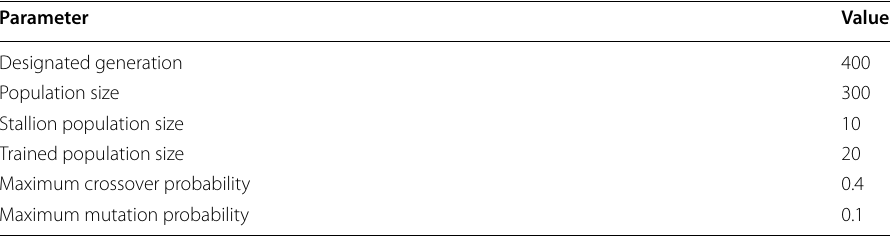
Table 2 Configuration of MOGA Parameter Values Designated generation 400 Population size 300 Stallion population size 10 Trained population size 20 Maximum crossover probability 0.4 Maximum mutation